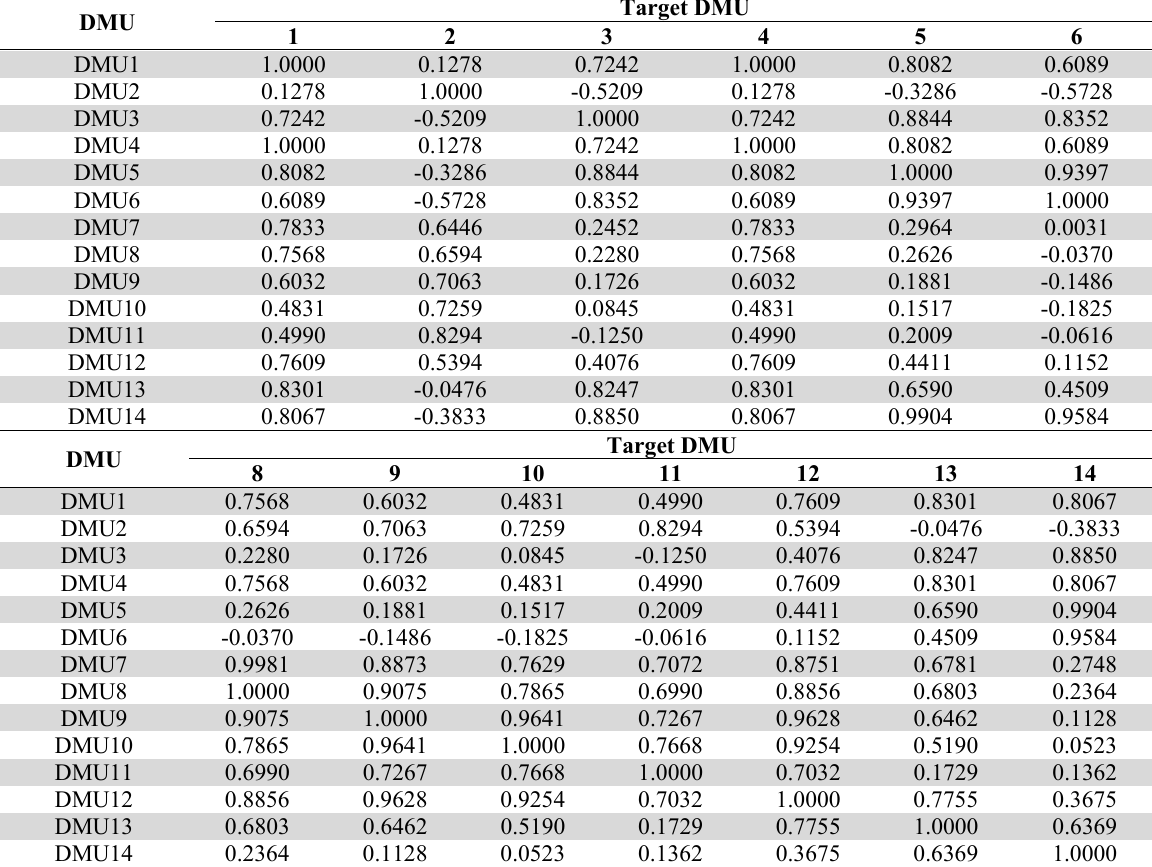
Correlation matrix for fourteen international passenger airlines